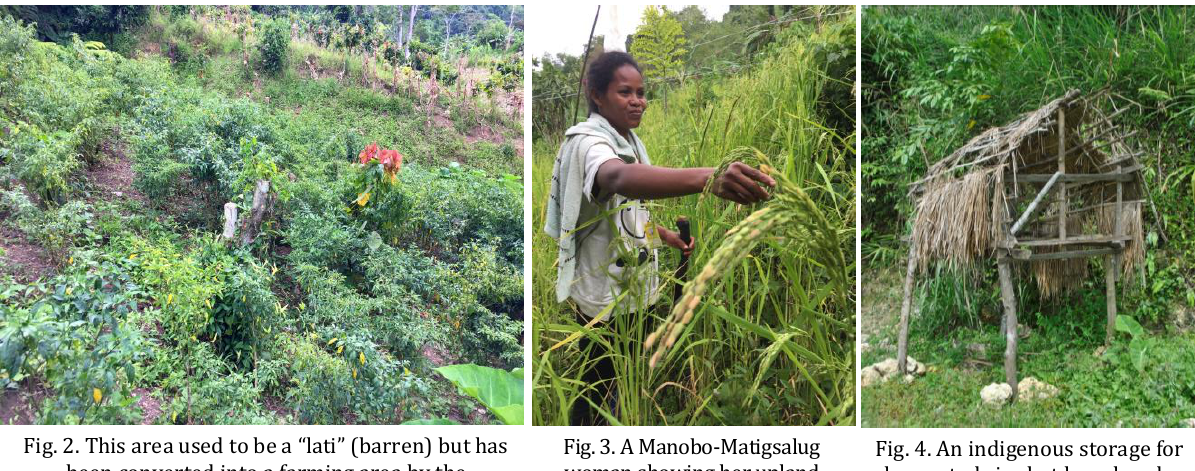
Fig. 3. A Manobo-Matigsalug Fig. 4. An indigenous storage for woman showing her upland harvested rice but has already rice called “dinorado” gone a modification in these (rice for subsistence) contemporary